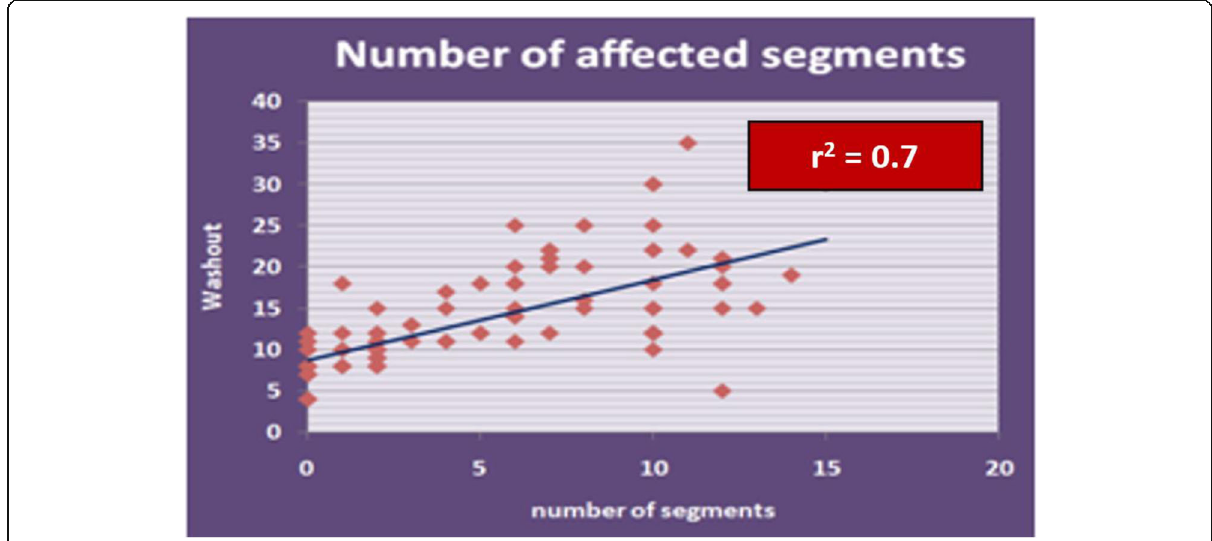
Fig. 5 GWR correlation with affected segment